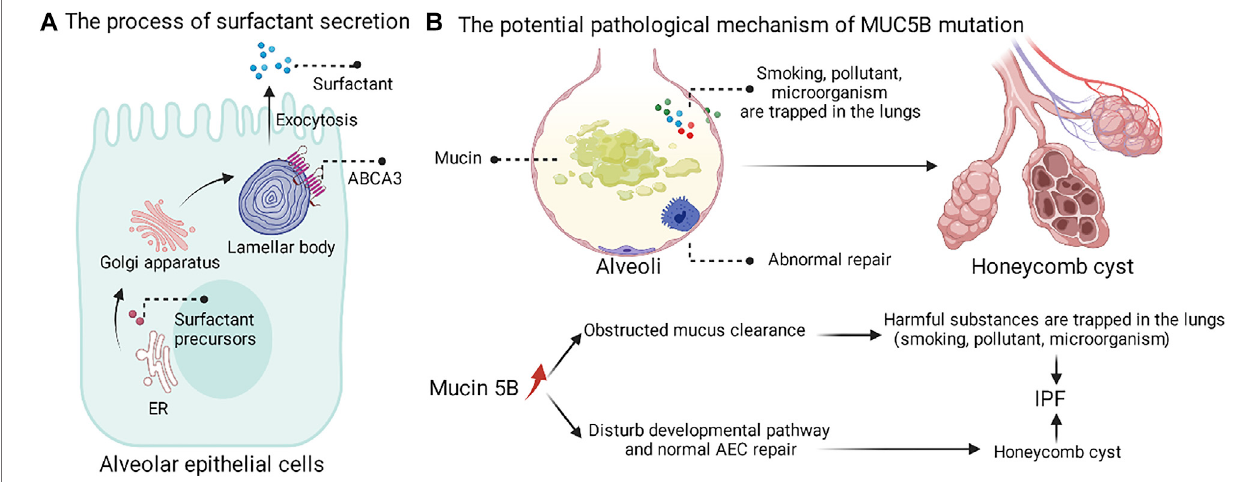
FIGURE 4 | The process of surfactant secretion and the potential pathological mechanism of MUC5B mutation. (A) The surfactant precursors are synthesized on theendoplasmicreticulum,followedbyGolgimodi fi cations,and fi nallysecretedintotheperipherybycytosolicexocytosisofthelamellarbody. (B) MUC5Bmutationmay promote the retention of harmful substances in the lung and interfere with the normal repair of